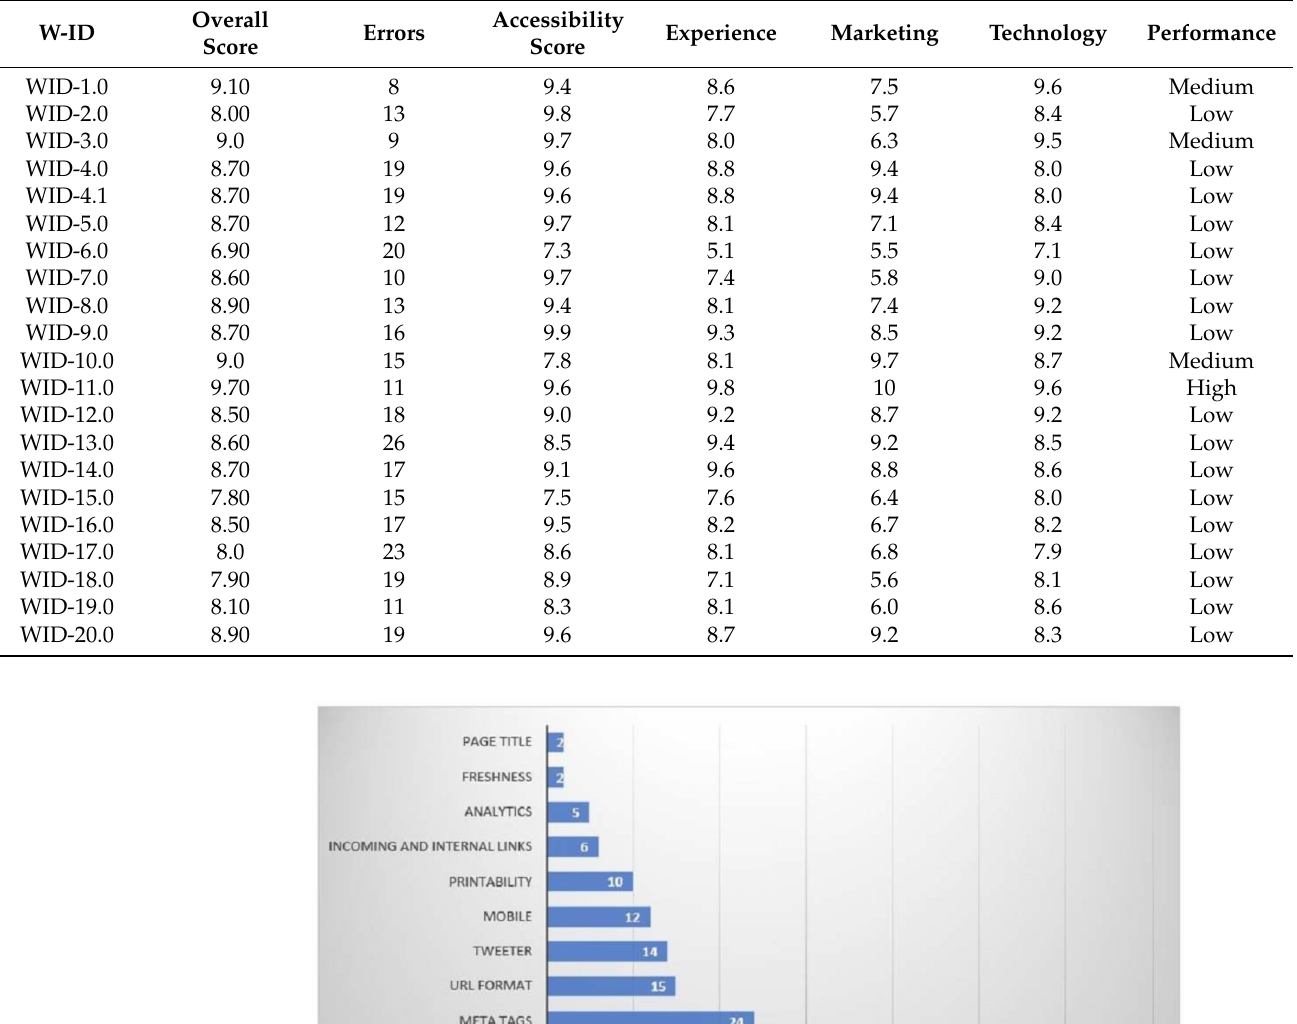
Table 6. Nibbler test result for twenty-eight government COVID-19 information websites.